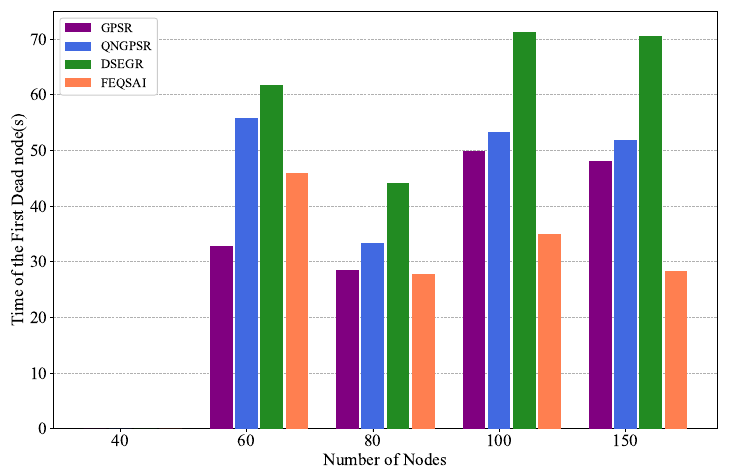
Figure 10. Performance comparison of the time of the first dead node among GPSR, QNGPSR, DSEGR, and FEQSAI with different node